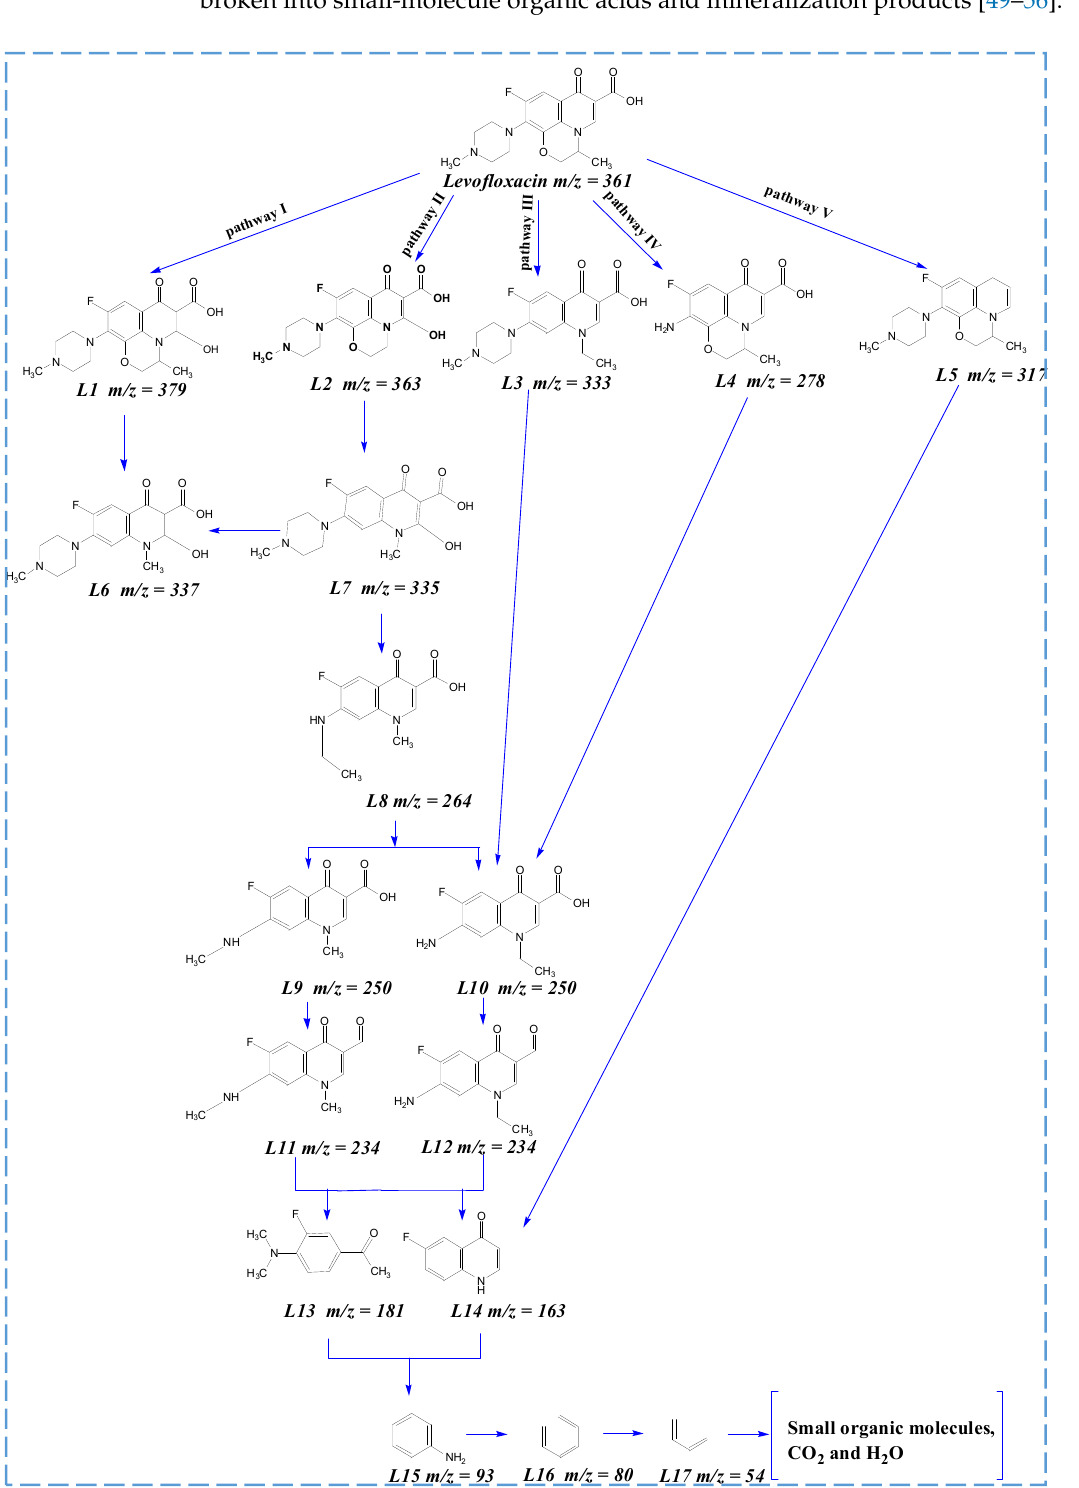
Figure 8. Proposed degradation pathways of LVX during electrooxidation reaction.